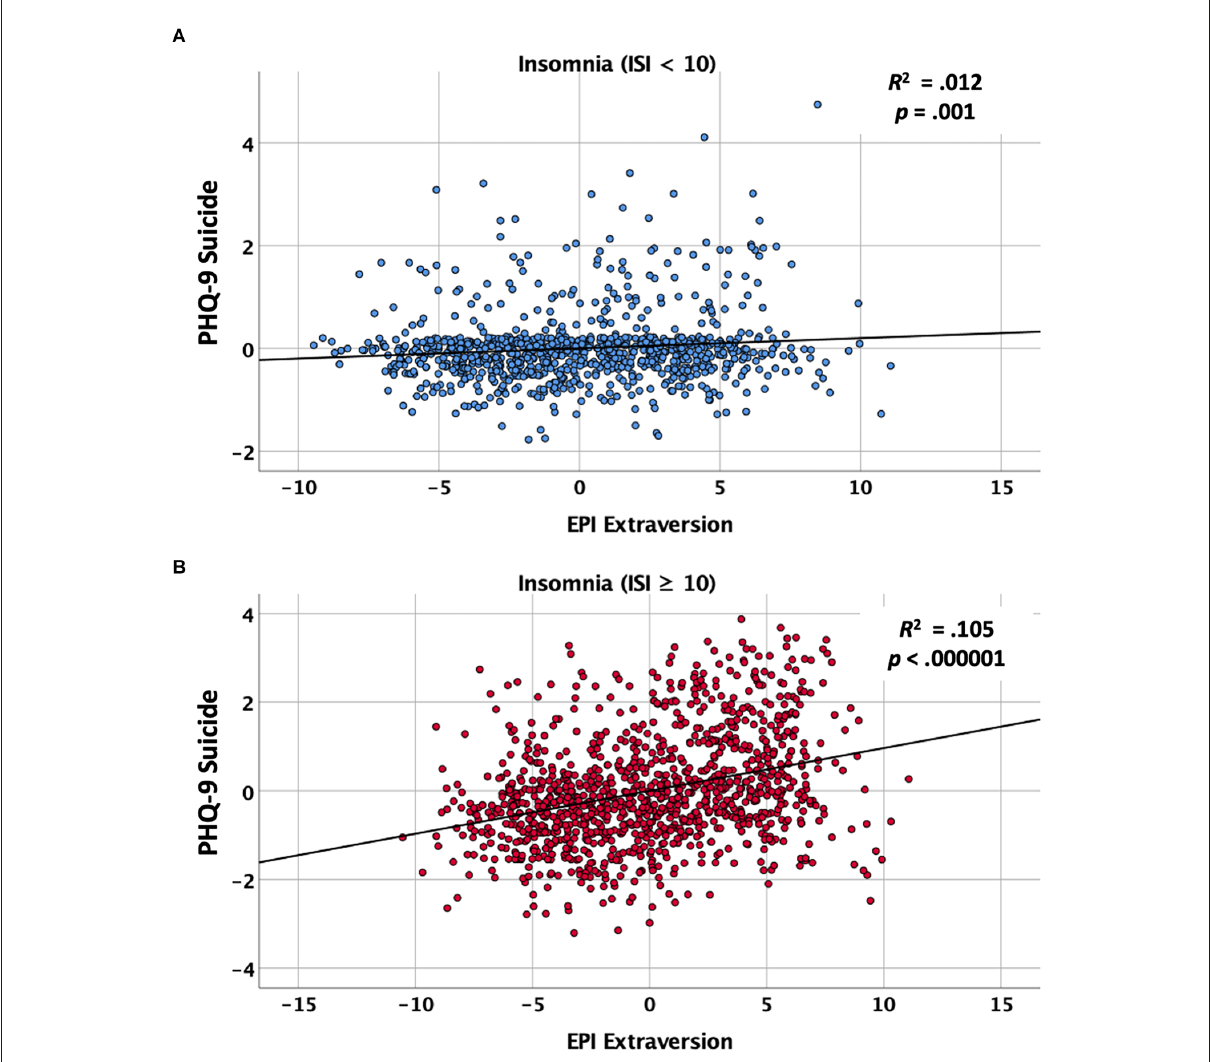
FIGURE3 Partial regression plots showing the association between baseline trait extraversion as measured by the Eysenck Personality Inventory (EPI) and suicidal ideation on the composite Suicide Ideation (SI) index after controlling for loneliness and depression. (A) Partial regression plot for individuals scoring low ( < 10) on the Insomnia Severity Index (ISI). (B) Partial regression plot for individuals scoring high ( ≥ 10) on the